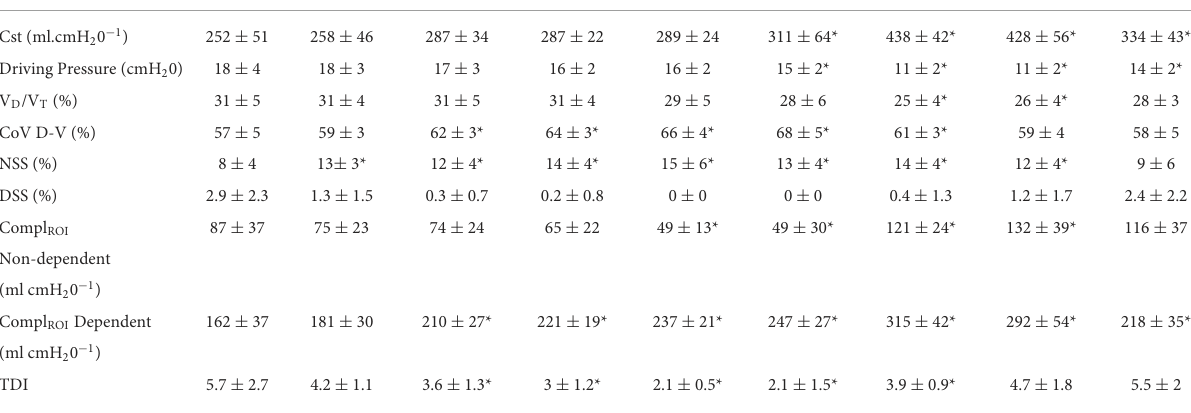
TABLE 1 Lung mechanics and electrical impedance tomography data.